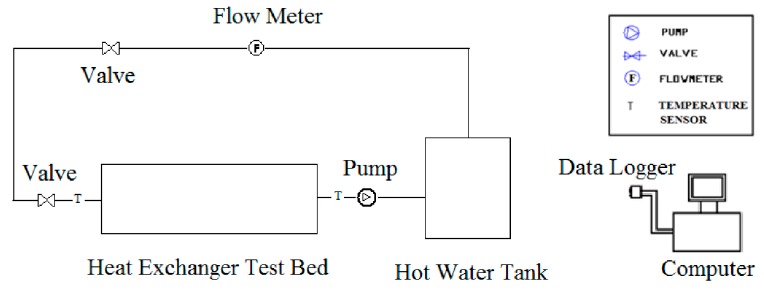
Figure 11. Heat exchanger test rig.